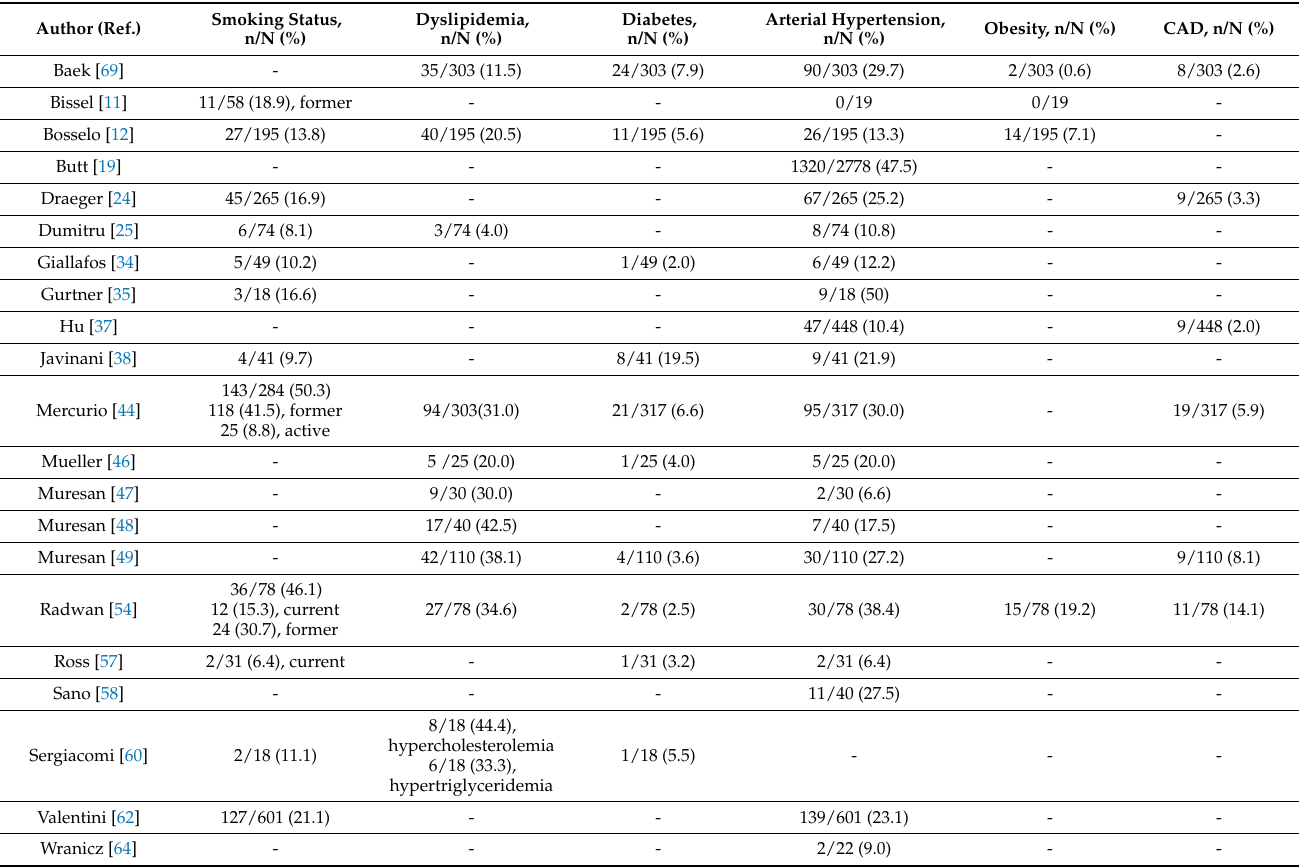
Table 2. Characteristics of SSc patients from cohorts—general cardiovascular risk